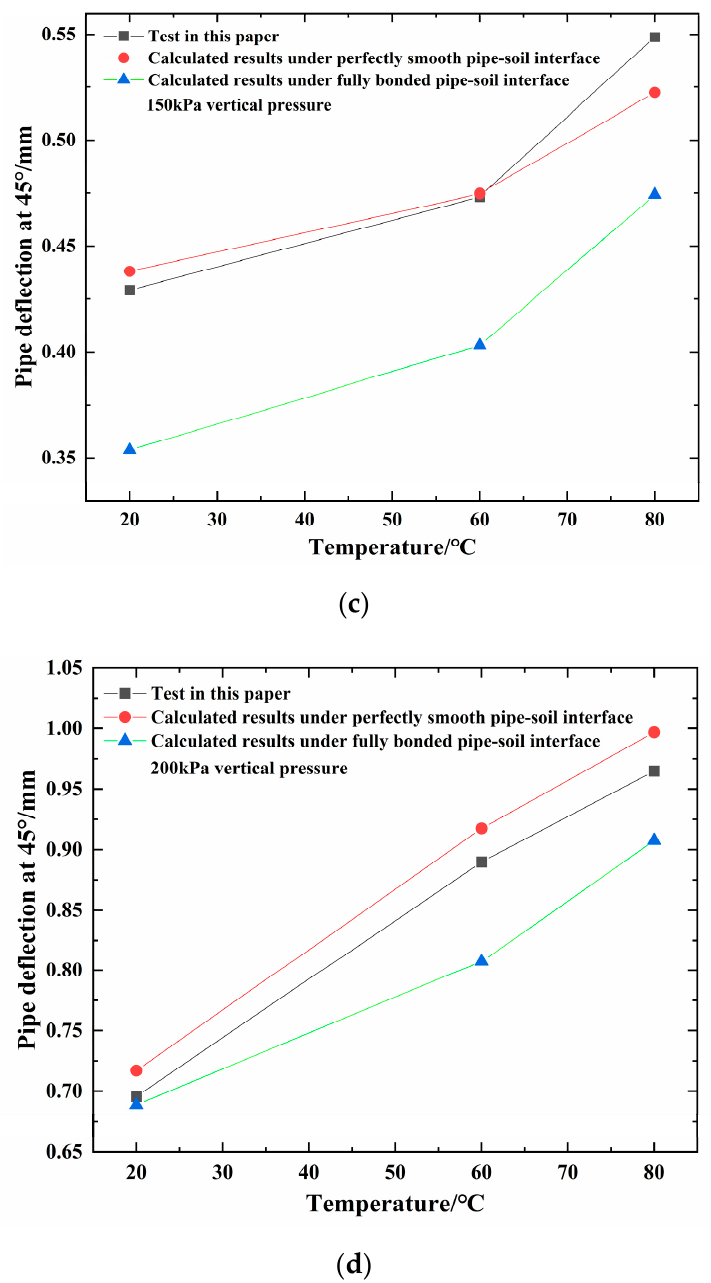
Figure 6. The variations of pipe deflections at 45° versus temperature: ( a ) 50 kPa; ( b ) 100 kPa; ( c ) 150 kPa; ( d ) 200 kPa.